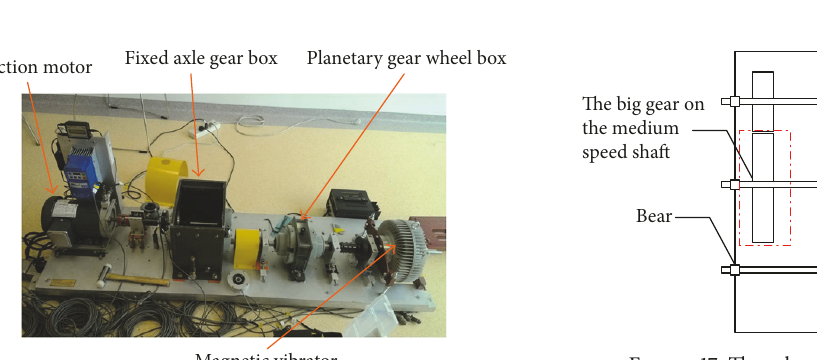
Figure 17: The schematic diagram of fixed axis